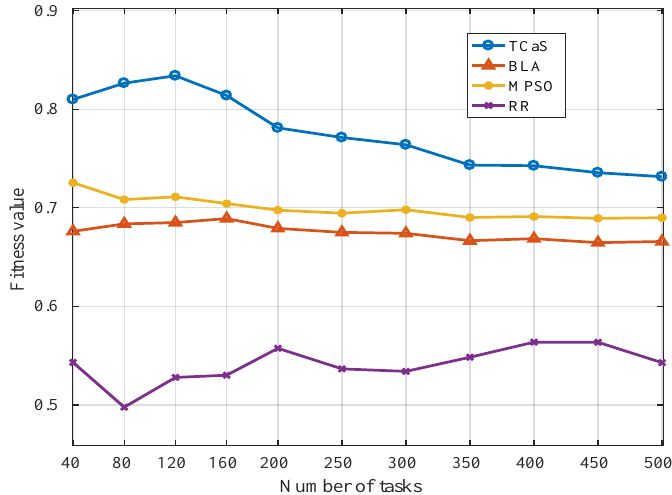
Figure 6. Time–cost trade-off comparison of the four